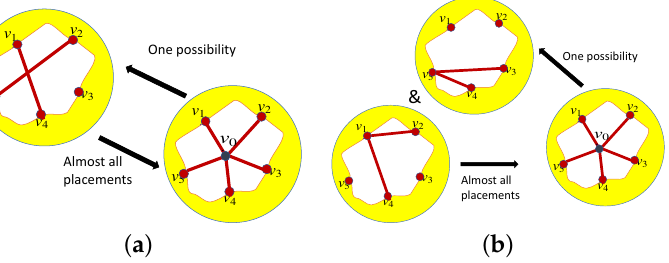
Figure 67. Two ways to add degree 5 vertices. ( a ) is X replacement and ( b ) is double- V replacement. At least one of these will apply when a degree 5 vertex is removed/added for an independent